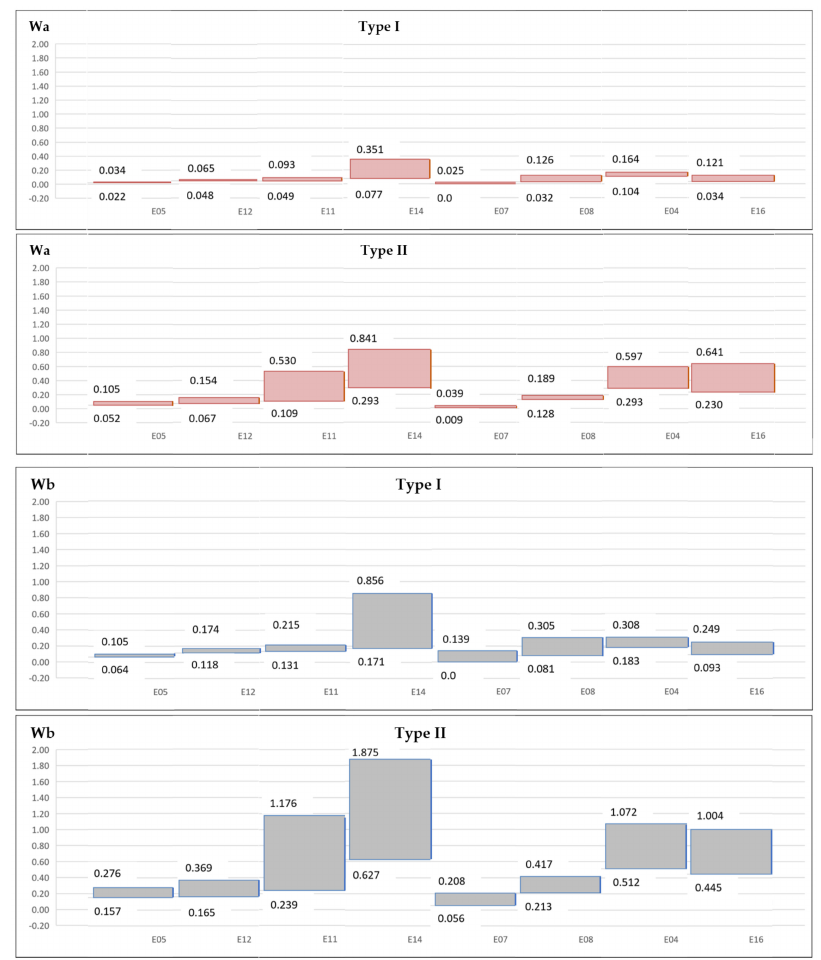
Figure 10. Wa and Wb delamination